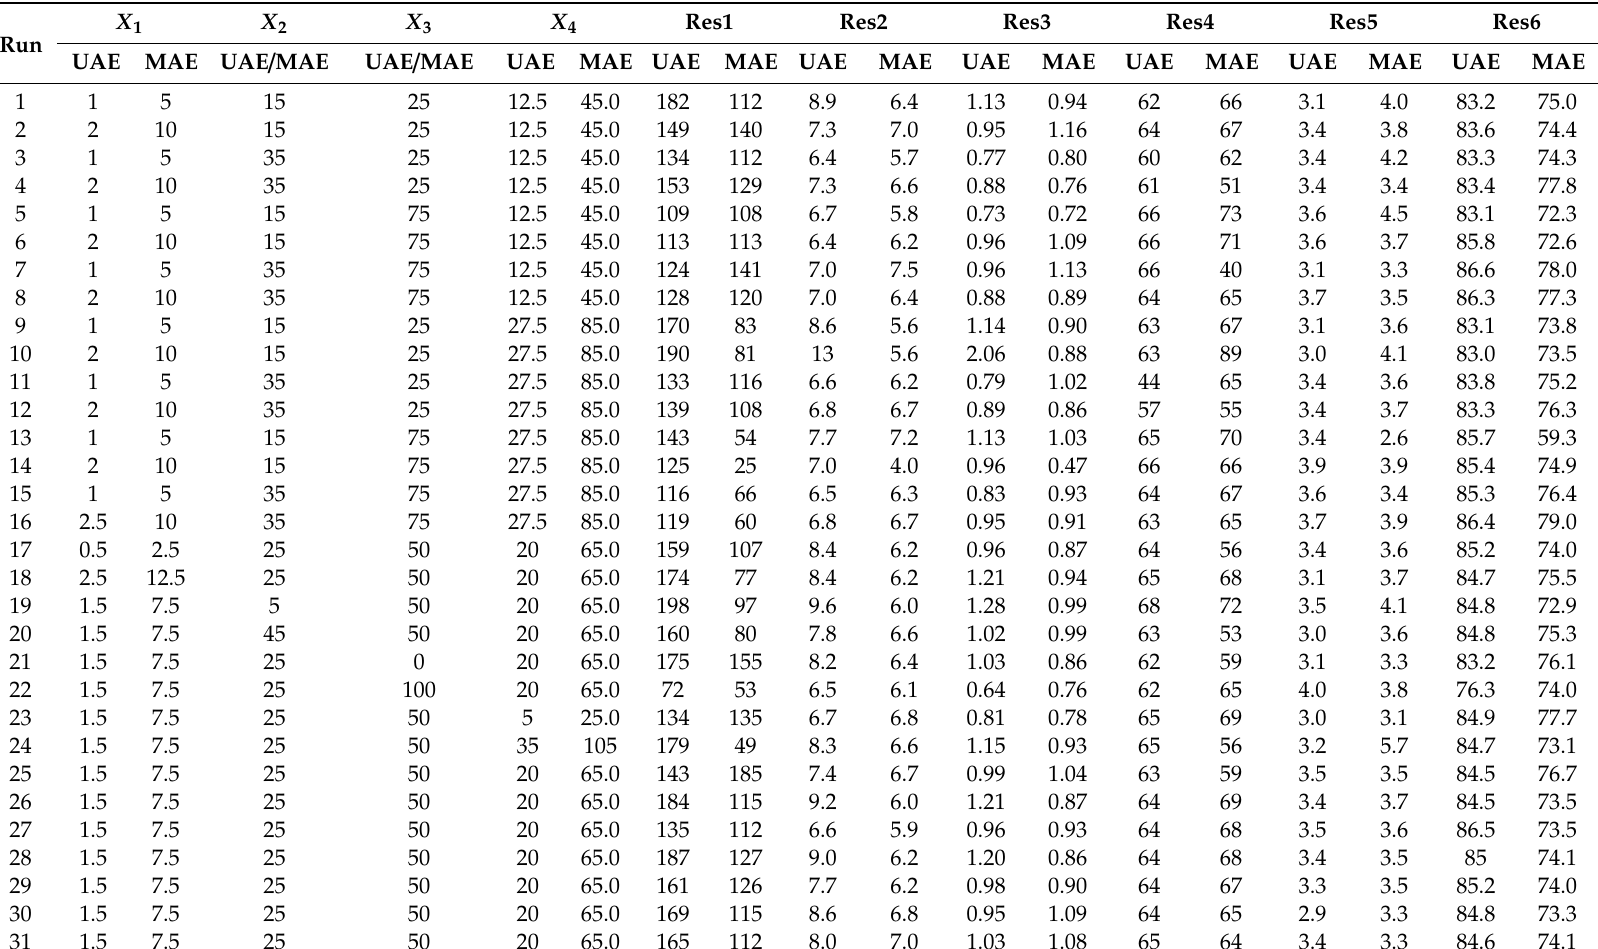
Table 2. Central composite design and experimental data for 4-level-4-factor response surface